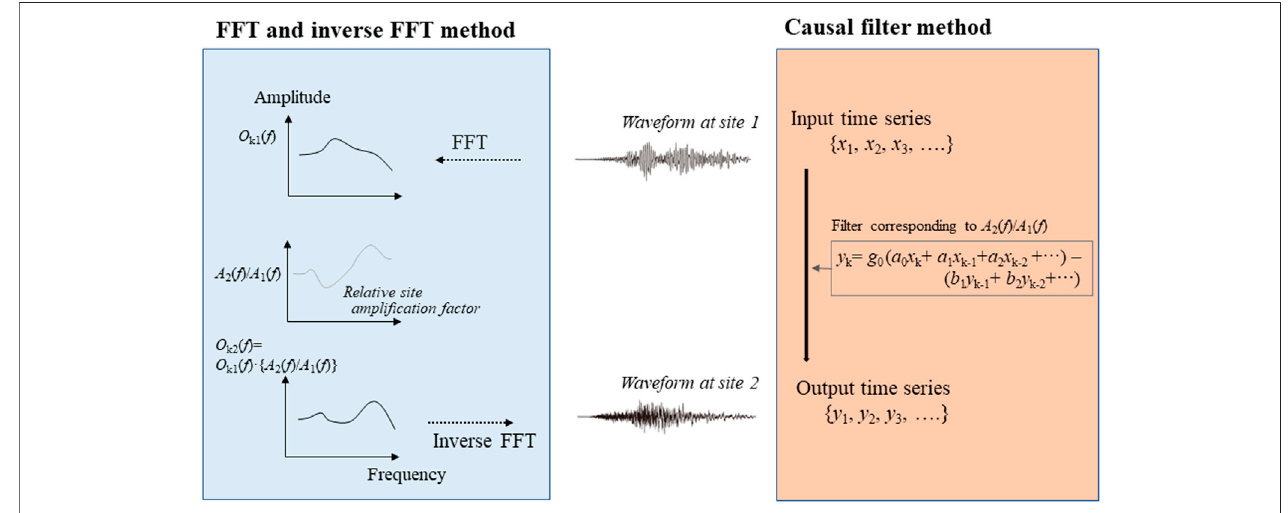
FIGURE5 | Comparison ofthecausal fi ltermethod withthe FFT(and inverse FFT) method. In theFFTmethod,the frequency-dependent site ampli fi cation factor is corrected in the frequency domain. In the causal fi lter method, it is done in the time domain.